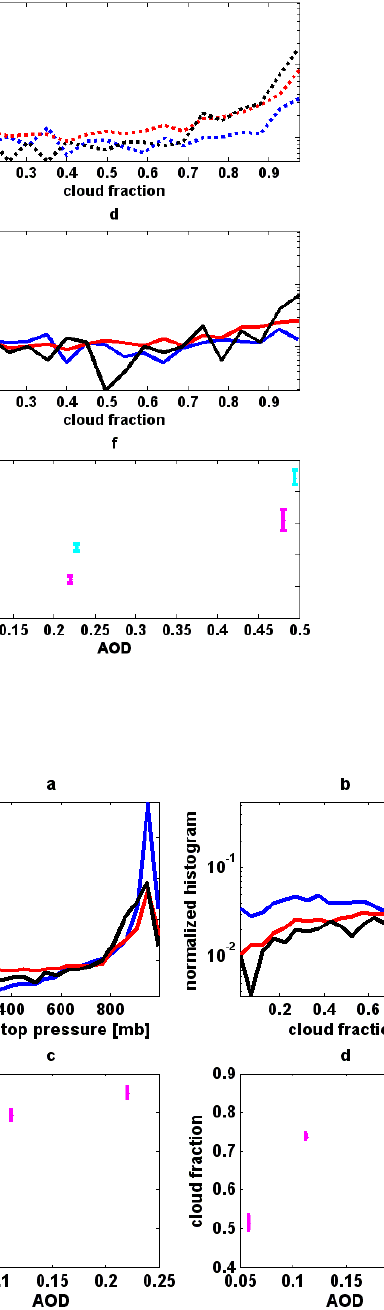
Fig. 7. MODIS cloud data vs. GOCART AOD analysis for